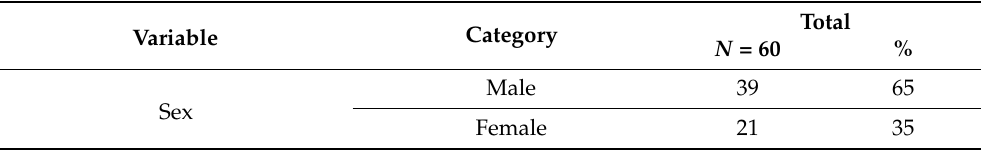
Table 2. Sample distribution according to the sociodemographic and clinical profile of the persons with special